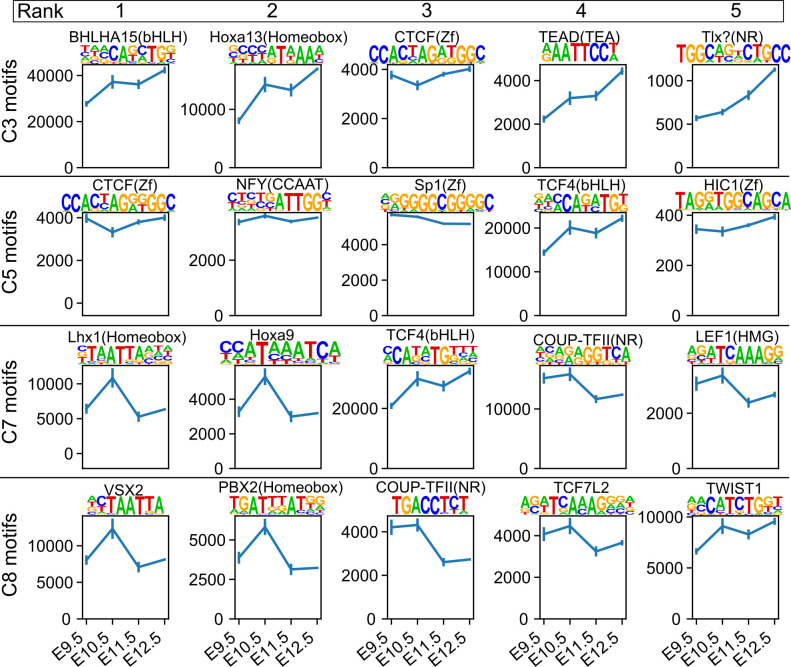
Counts of accessible motifs at each stage.The average number of top-ranked motifs identified by de novo motif discovery in Figure 6—figure supplement 4 are plotted against mouse embryonic stages. The average numbers were calculated using all three replicates of ATAC-seq peaks at each stage. Rows indicate clusters identified in Figure 6A; columns indicate motif rank. Error bars, SEM. C1–C8 correspond to the clusters in Figure 6A. Note that the number of CTCF motifs (top-ranked in C5) was relatively stable over time, which is consistent with the clustering analysis shown in Figure 6A. In addition, the number of motifs enriched for C3, such as BHLHA15, HOX13, TEAD, and Tlx?, increased over time. In contrast, COUP-TFII and TCF7L2 motifs decreased over time. Interestingly, LHX and HOX9 motifs were transiently increased at E10.5.